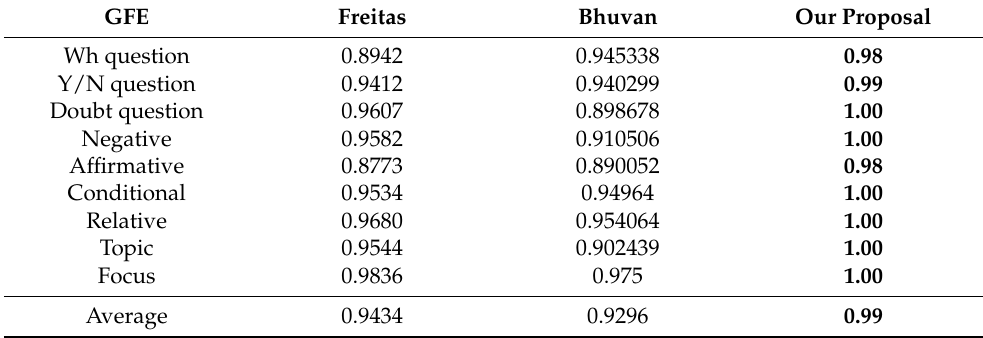
Table 1. F1 scores achieved by our proposed model and other state-of-art approaches using the dataset that stored grammatical facial expressions of the Brazilian sign language (Libras) made by subject one. Best results are in